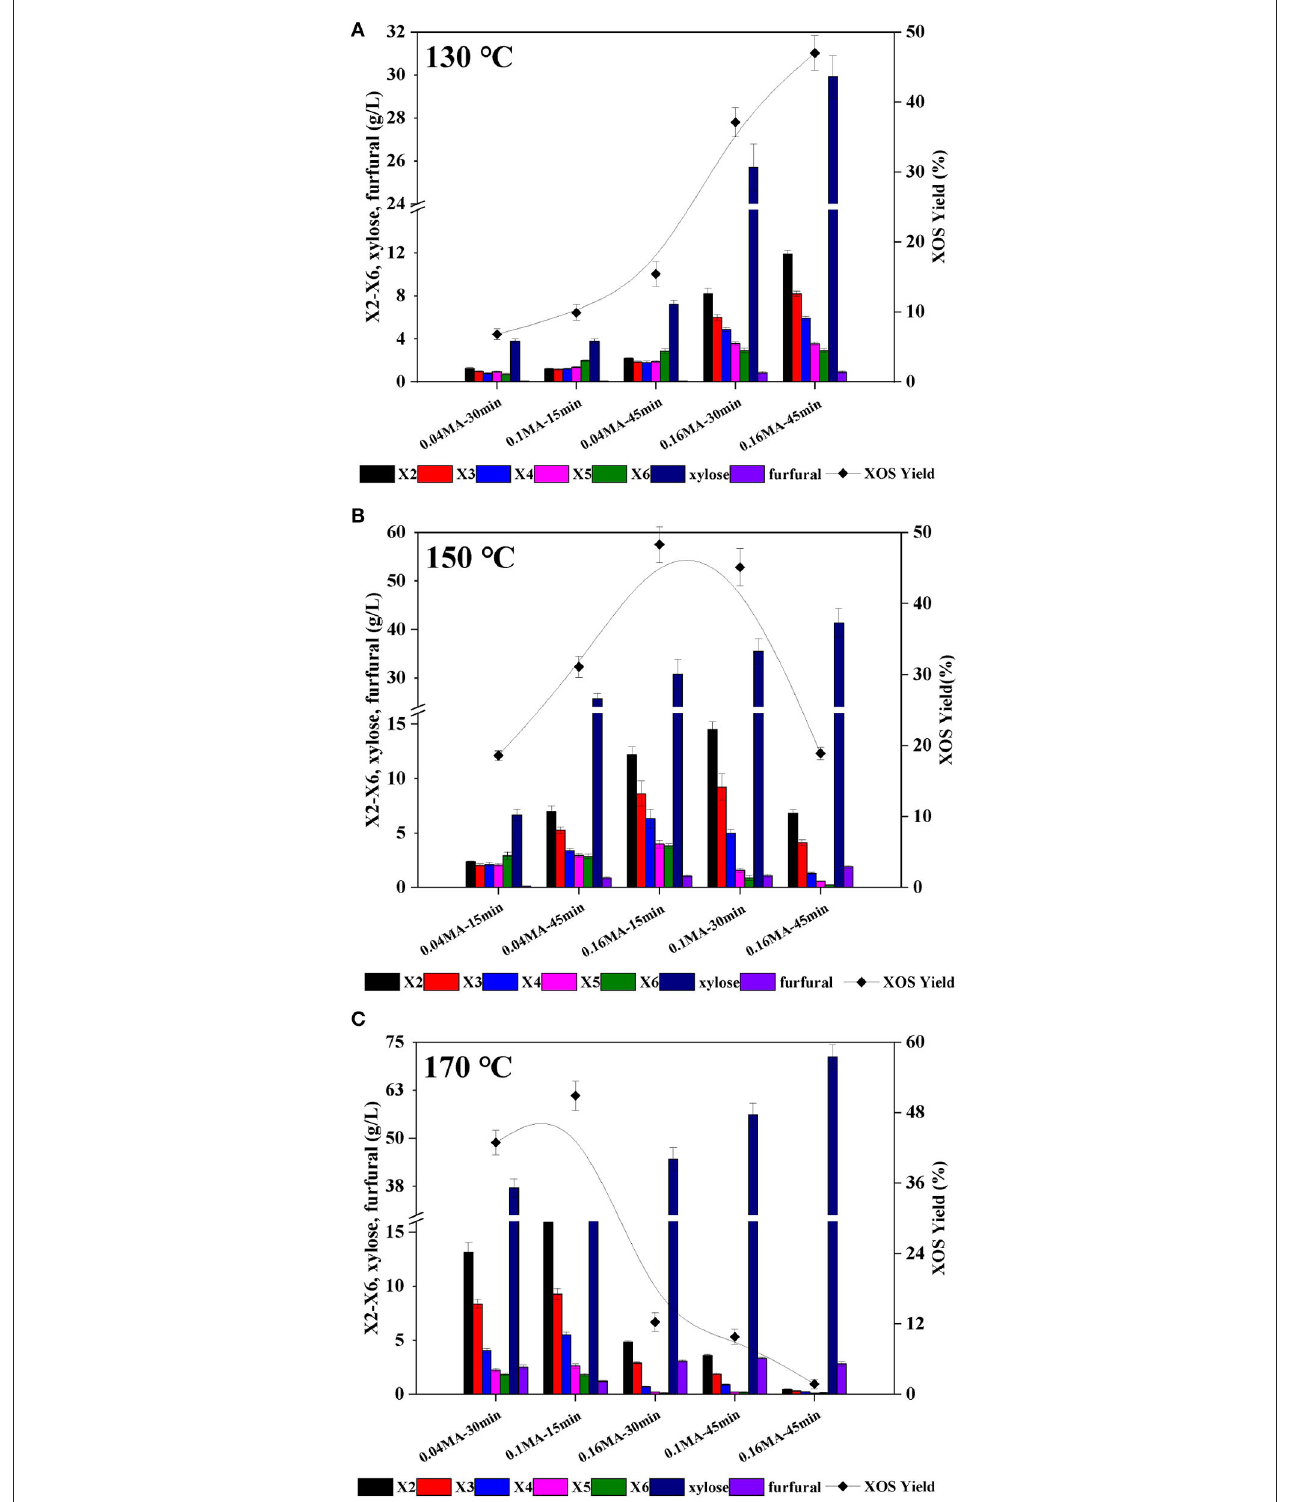
FIGURE 1 | Furfural, xylose, and X2-X6 distributions and XOS yields in xylan hydrolysates prepared using a range of MA concentrations, holding times, and temperatures: (A) 130 ◦ C; (B) 150 ◦ C; and (C) 170 ◦ C. X2: xylobiose; X3: xylotriose; X4: xylotetraose; X5: xylopentaose; X6: xylohexaose; XOS: xylooligosaccharides = X2 + X3 + X4 + X5 + X6; MA: maleic